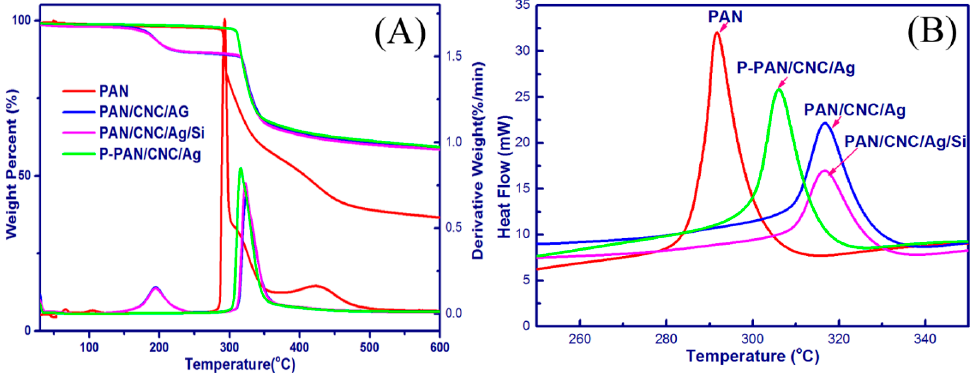
Figure 6. TG and DTG curves ( A ); and DSC curves ( B ) of the electrospun nanofibers.